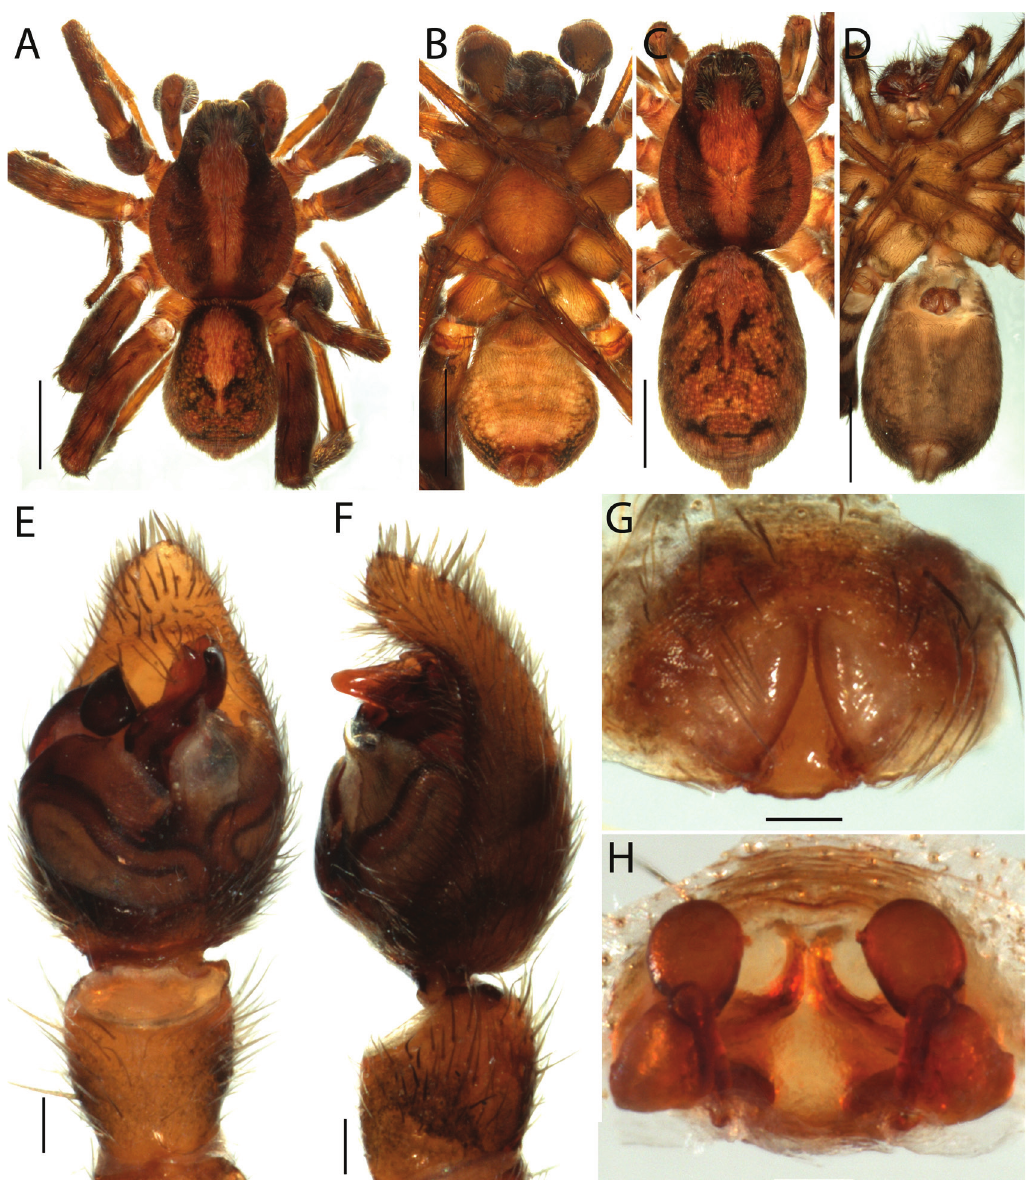
Figure 11. Artoria berenice (L. Koch, 1877), male and female (AM KS75080): A , male habitus, dorsal view; B , male habitus, ventral view; C , female habitus, dorsal view; D , female habitus, ventral view; E, male pedipalp, ventral view; F , male pedipalp, retrolateral view; G , epigyne, ventral view; H , epigyne, dorsal view. Scale bars: habitus 1.0 mm; pedipalp, epigyne 0.1